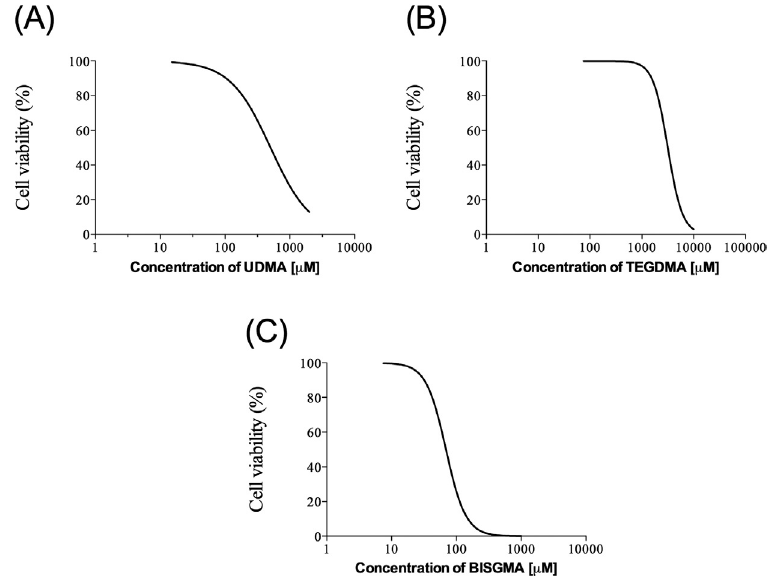
Figure 4- Dose-response curves for peripheral blood mononuclear cells (PBMC) treated with monomers, after 20 hours of exposure. Cell viability was assessed by a MTT-based assay and expressed as a percentage of control (media). Curves correspond to a sigmoidal fitting. Data from 8 donors are shown. All experiments were performed in